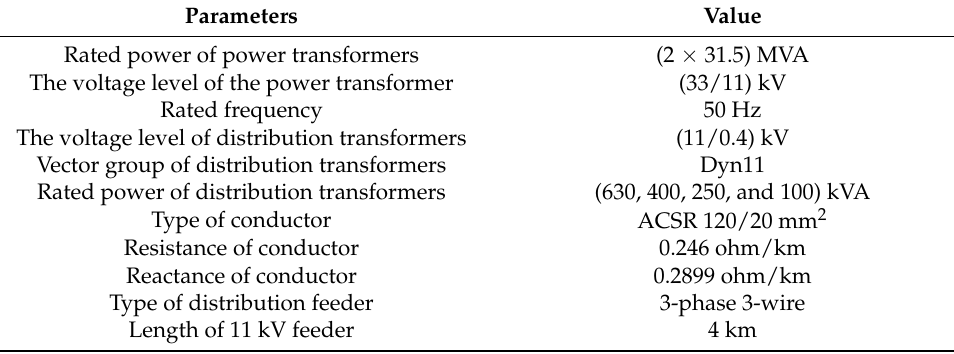
Figure 10. Simulation of the real feeder. Table 1. The parameters of the study network. Parameters